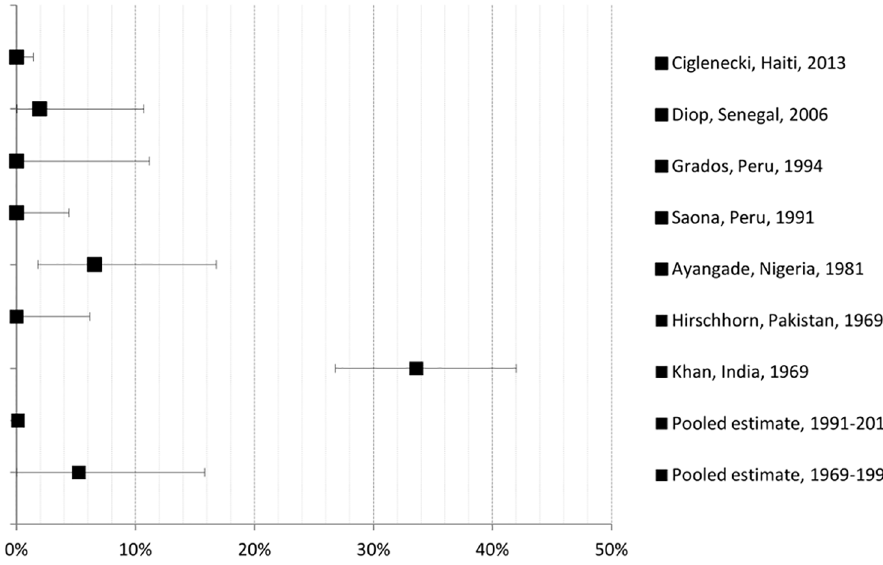
Fig 4. Maternal death rate with cholera: study and pooled estimates per 100 pregnancies with 95% confidence intervals.